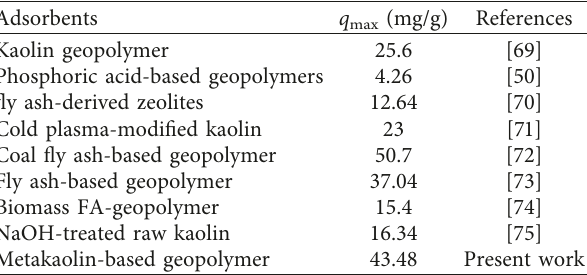
Metakaolin-based